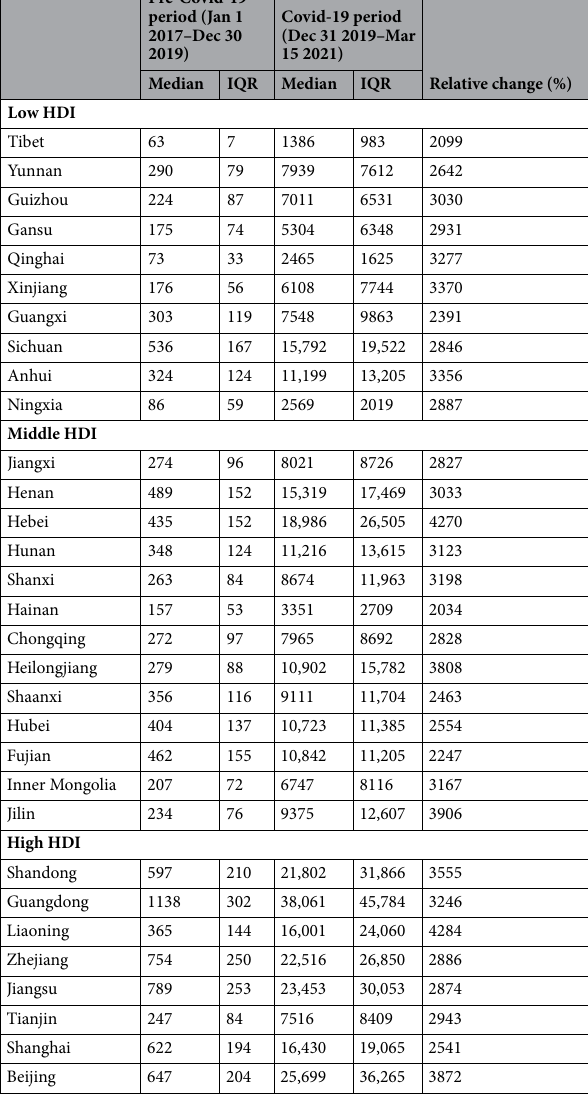
Table 1. Comparison of search index in the COVID-19 and pre-COVID